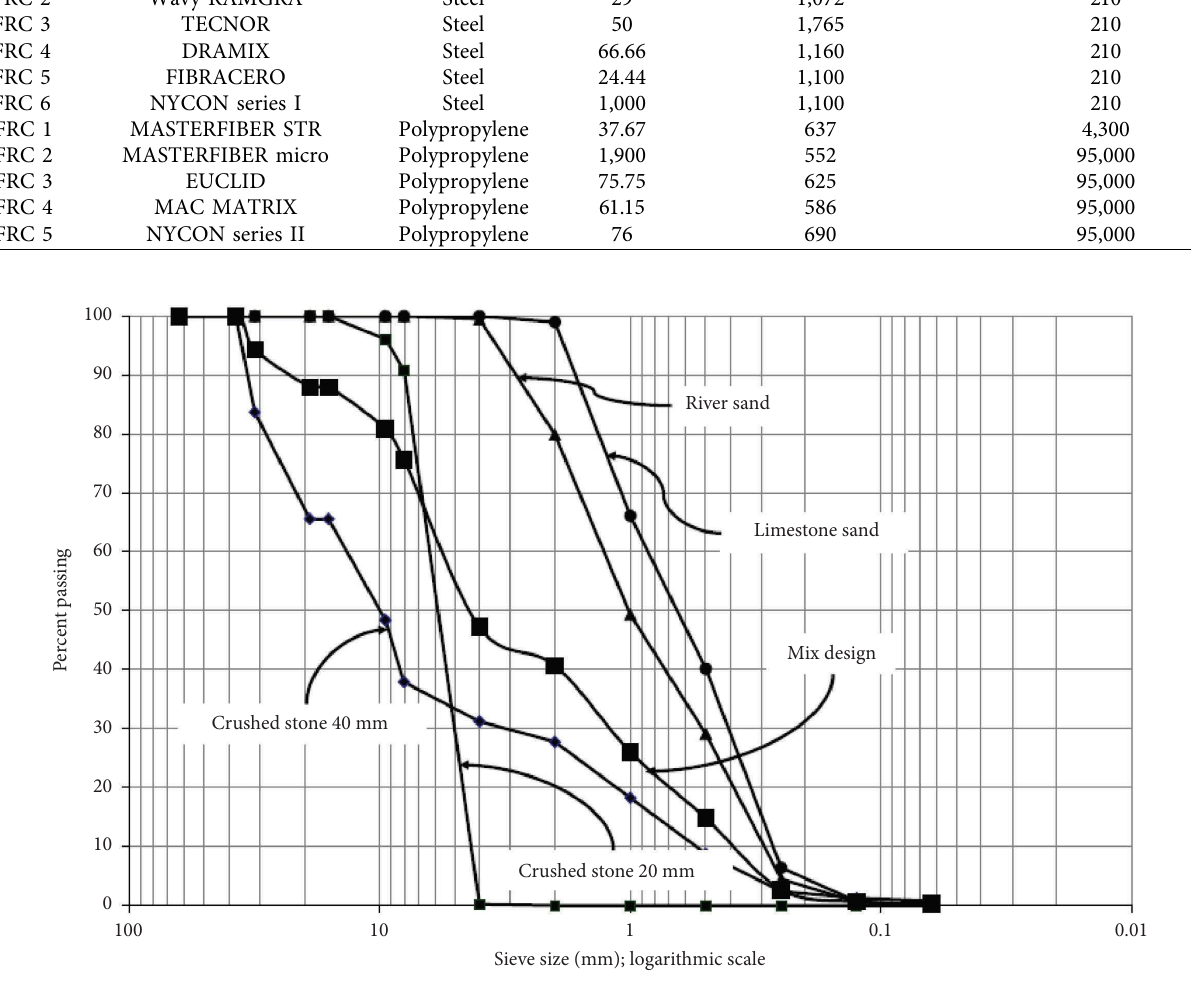
Figure 2: Granulometric curve.